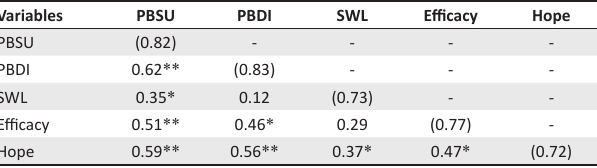
TABLE 1: Correlation matrix for the latent variables.